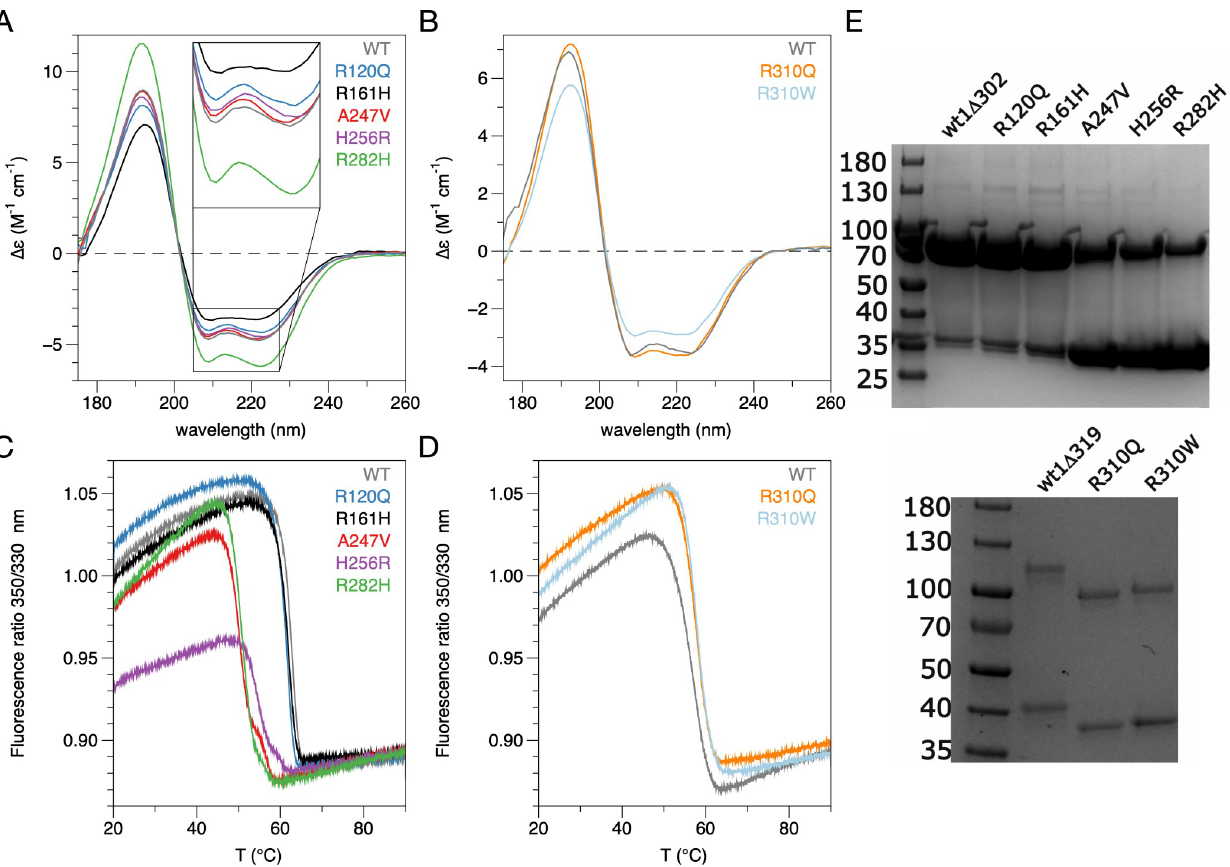
Fig 4. Folding and stability of GDAP1 as affected by CMT mutations. A. SRCD spectra for the mutants in the GDAP1 Δ 303–358 construct. The spectral shape is most different for R161H, and for R282H, the spectral amplitude is increased, but the shape does not change compared to wild-type GDAP1. B. SRCD spectra for the mutants in GDAP1 Δ 319–358. C-D. nanoDSF analysis for the mutants in GDAP1 Δ 303–358 (C) and GDAP1 Δ 319–358 (D). The curves shown are each average of three independent nanoDSF curves run in parallel. E. Non-reducing SDS-PAGE analysis of all studied variants. Top: variants in GDAP1 Δ 303–358; wt1 Δ 302 refers to the wild-type construct. Bottom: variants in GDAP1 Δ 319–358; wt1 Δ 319 refers to the wild-type construct. For the longer constructs (panel below), the added segment is most likely a membrane-binding motif, and the mutations may affect membrane interactions; this